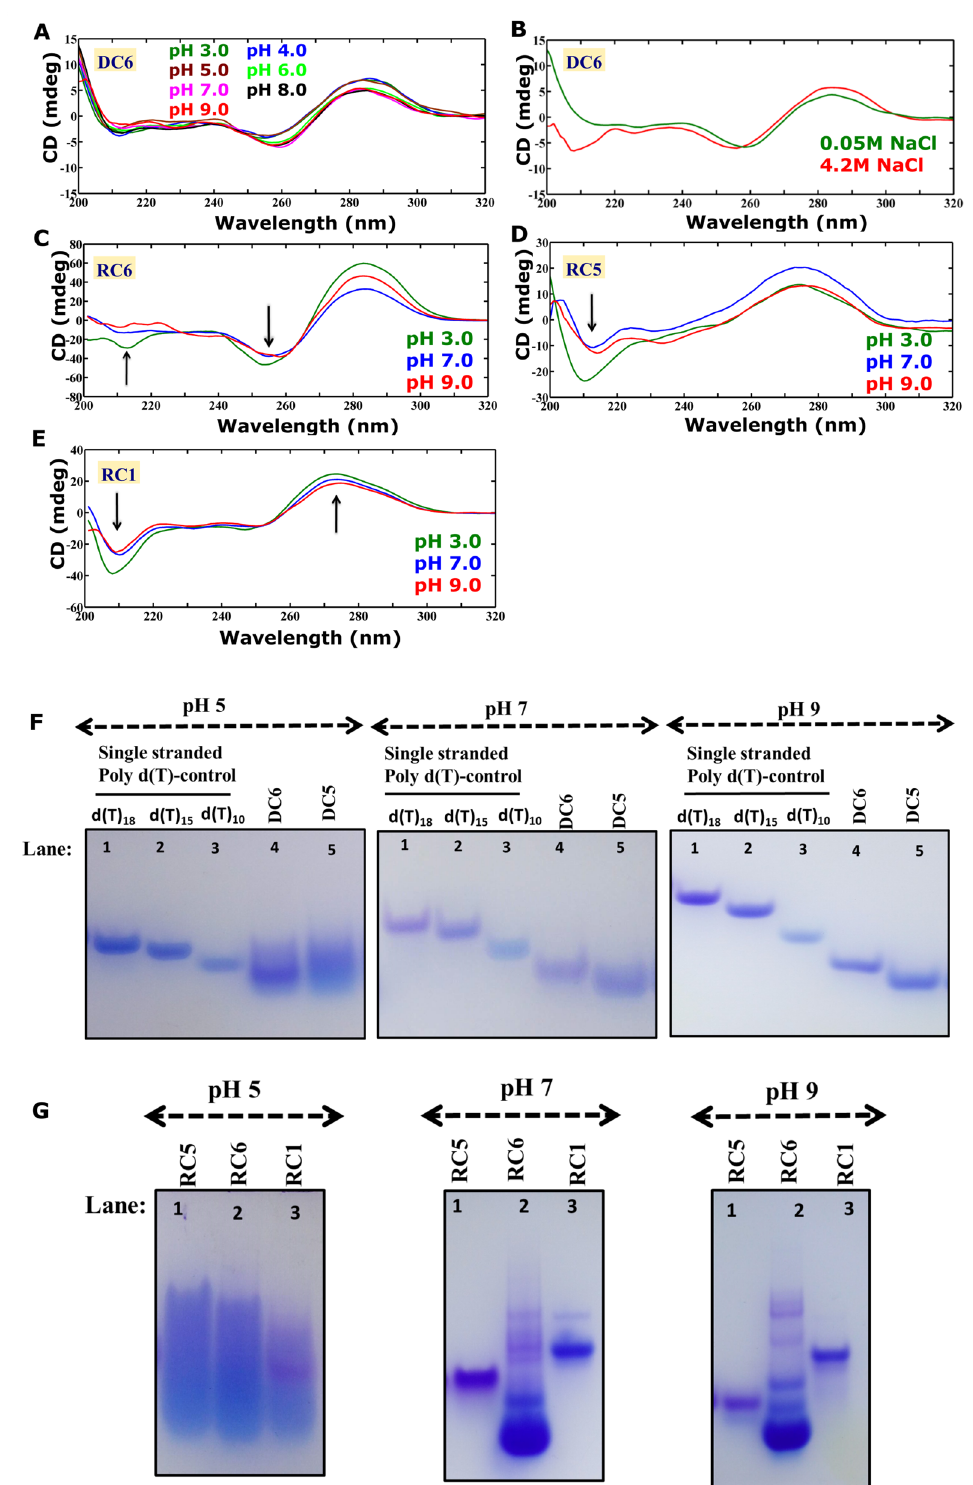
Figure 5. Circular dichroism spectra and EMSA corresponding to the DNA and RNA duplexes comprising of CCG repeats. ( A ) pH and ( B ) salt-dependent CD spectra showing the preference for duplex conformation by DC6 that contain 6 C…C mismatches. Preference for ( C , D ) i-motif like conformations by RC6 and RC5, and ( E ) A-form conformation by RC1. The figures ( A – E ) were plotted by using MATLAB 7.11.0 software (www. mathw orks. com). Gel picture corresponding to ( F ) DC6 and DC5 (lanes: 4, 5) and ( G ) RC5 (lane: 1), RC6 (lane: 2), and RC1 (lane: 3) sequences at pH 5 (left), pH 7 (middle), and pH 9 (right). The EMSA ( F , G ) samples were analyzed by 10% native PAGE and stained with Stains All dye. The unprocessed gel images ( F , G ) are incorporated in Supplementary Fig.